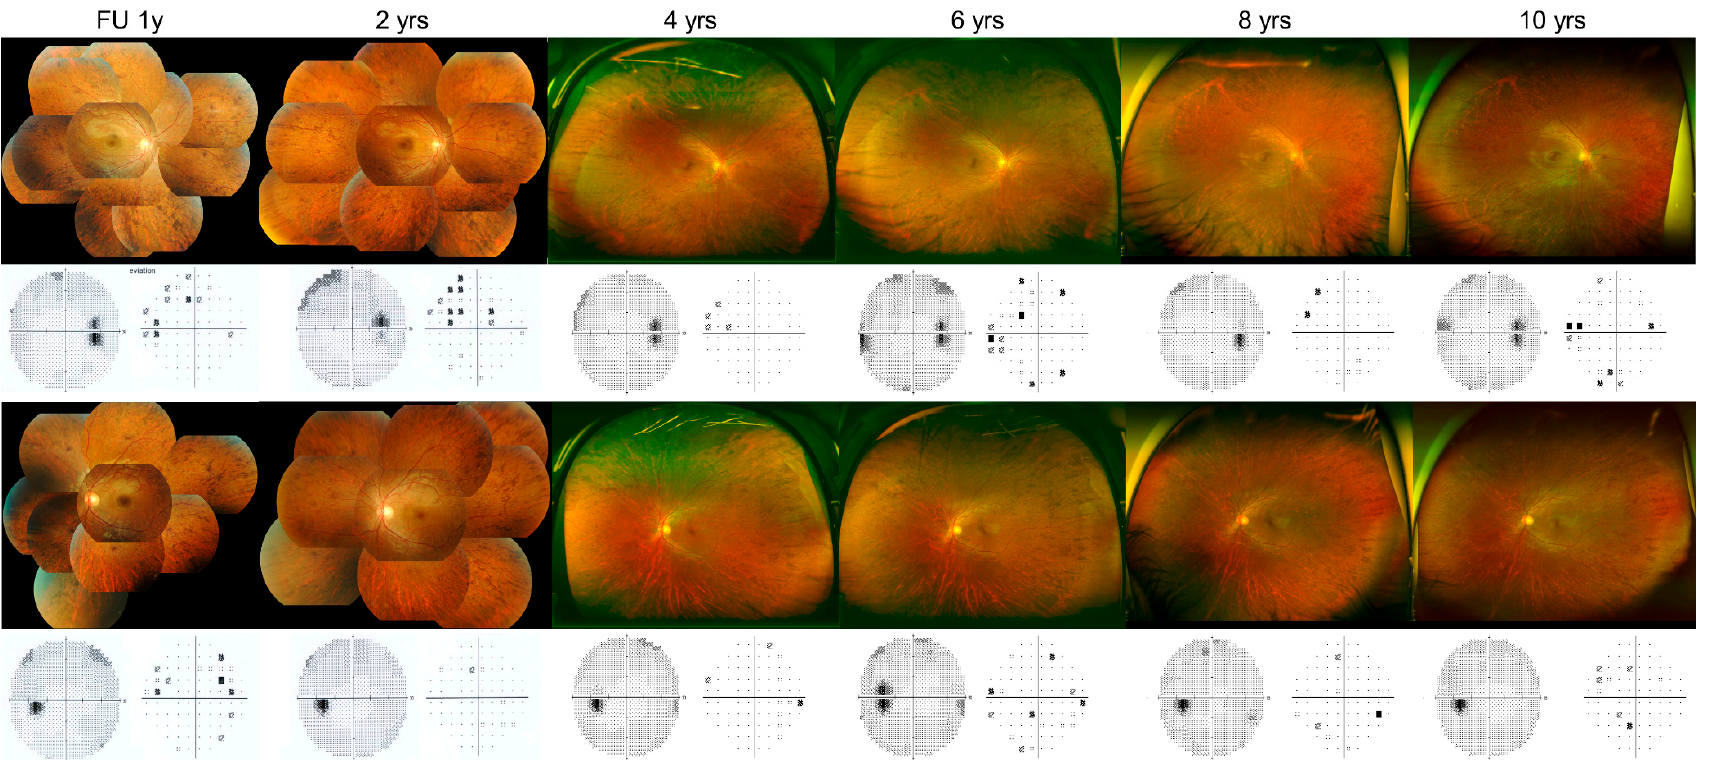
Figure 2. Serial peripheral fundus images and the visual fields of the same patient during the follow-up (FU) period.